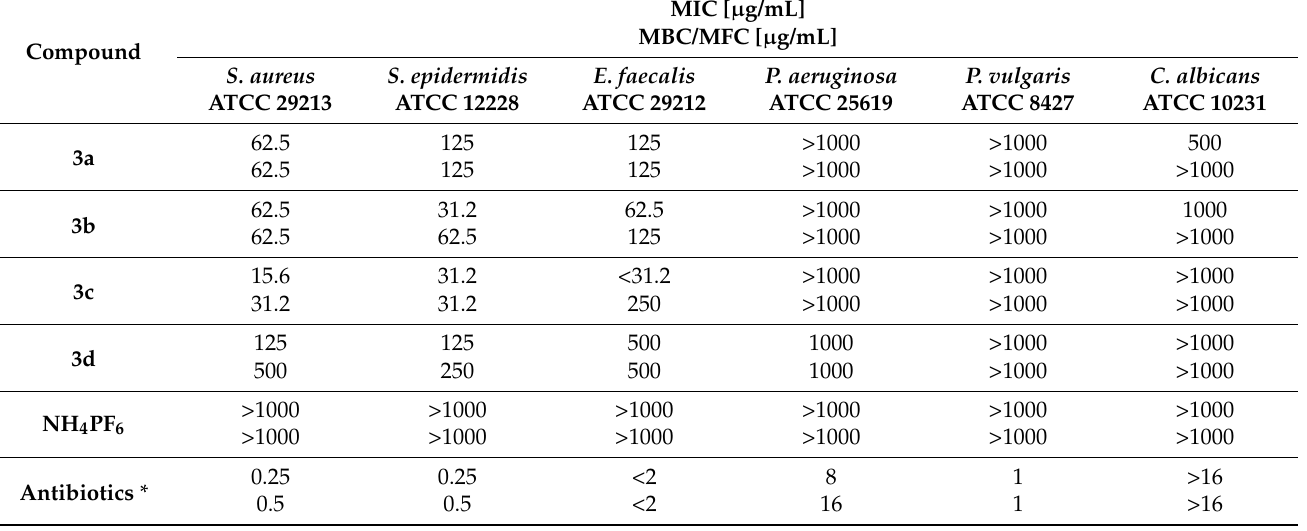
Table 2. The antimicrobial activity of arene-ruthenium(II) complexes with a